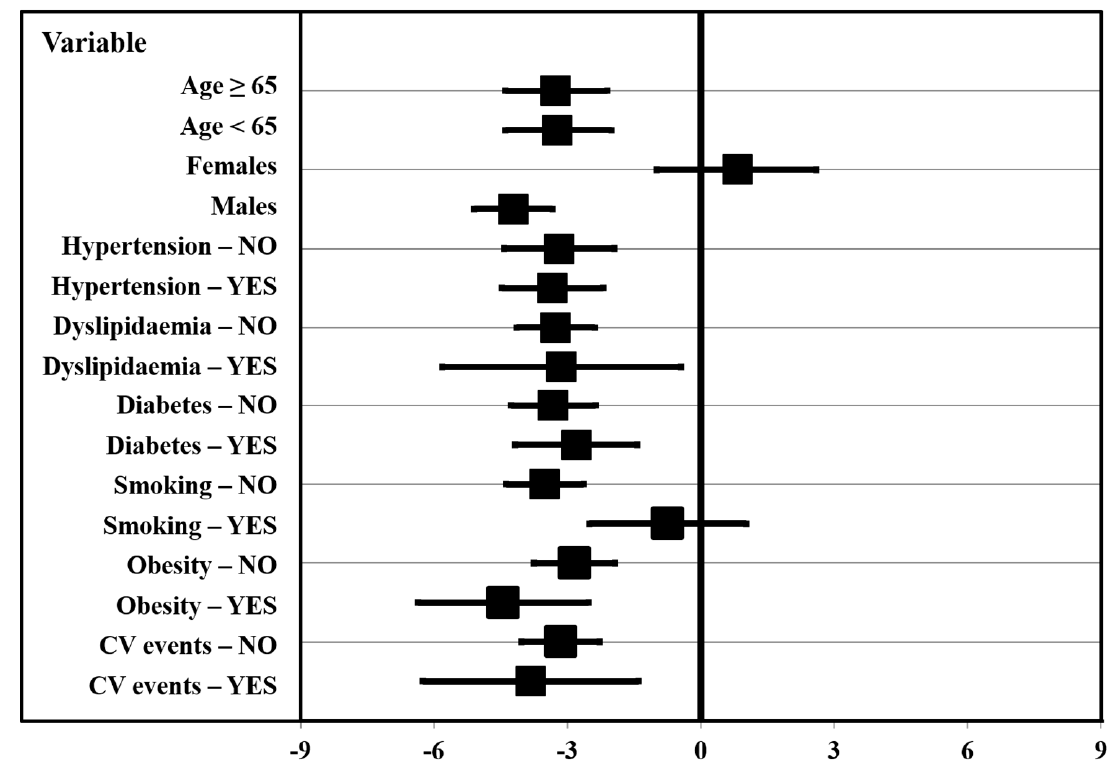
Figure 1. Difference in flow-mediated dilation (FMD) between convalescent coronavirus disease 2019 (COVID-19) patients and controls stratified according to demographic and clinical characteristics. CV: Cardiovascular.